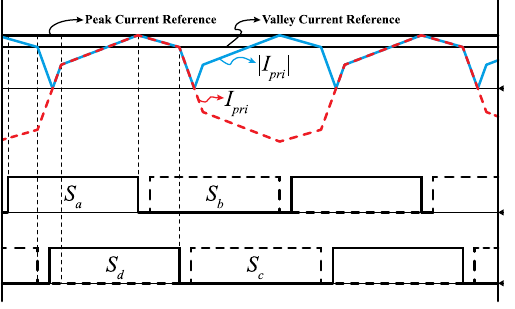
Figure 13. Primary-side current waveforms with the proposed HCMC for PSFB